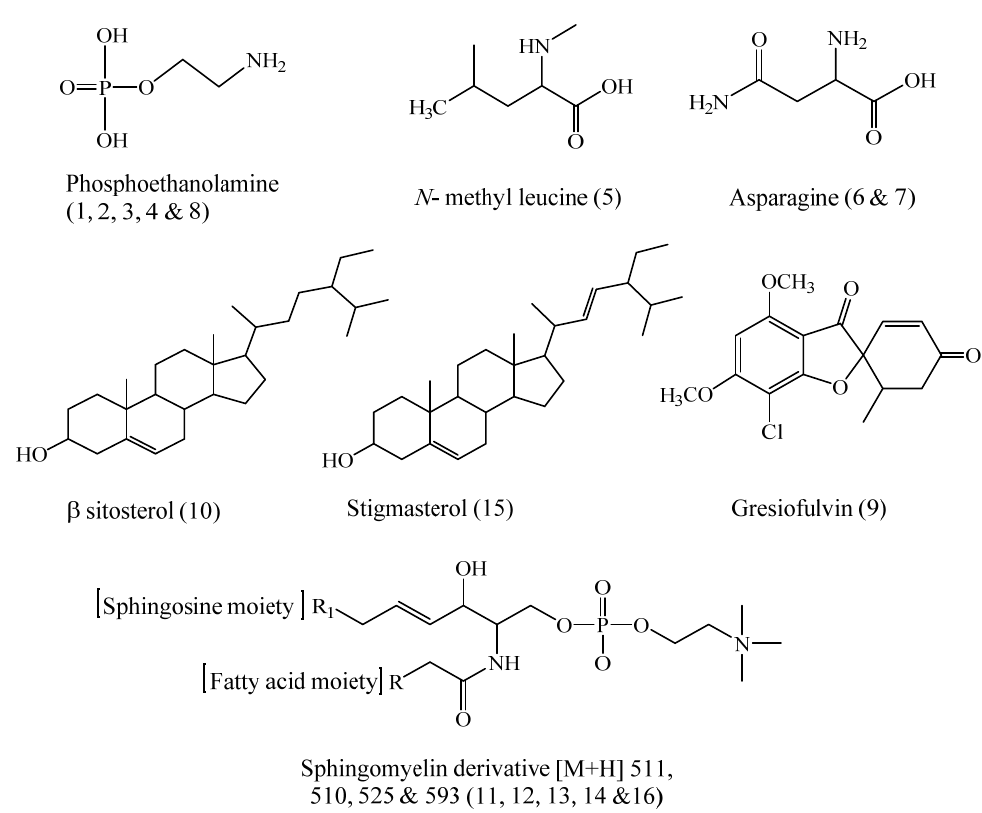
Figure 6. Chemical structures of the tentatively identified compounds from dichloromethane fraction of Cliona sp. Table 2. Metabolites tentatively identified in dichloromethane fraction using UPLC-ESI-MS/MS analysis in positive ionization mode.